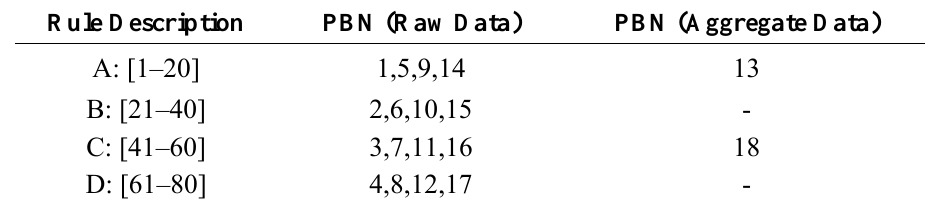
Table 4. Metadata in flash map blocks.